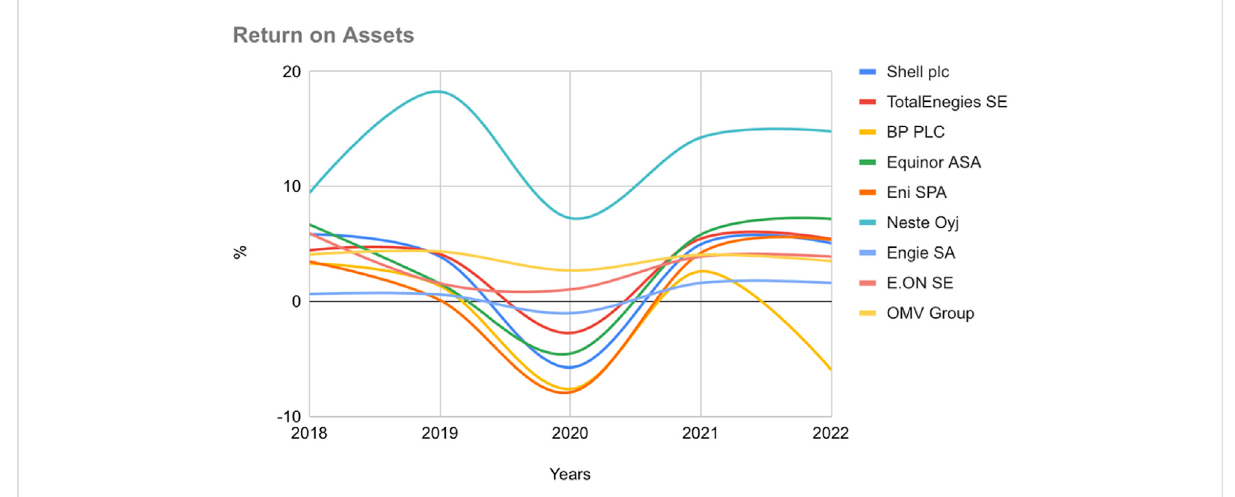
FIGURE 1 Line chart: Return on equity. Source: Own